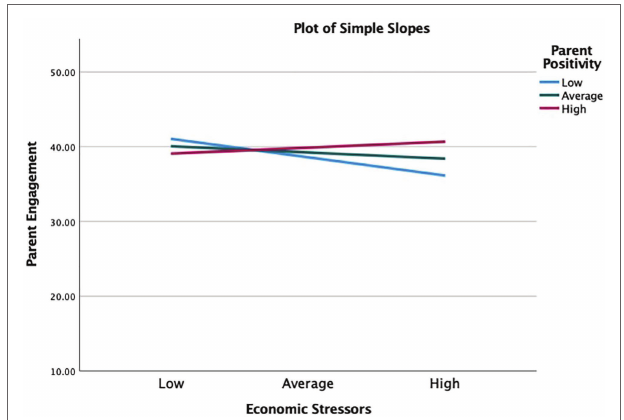
FIGURE 3 | Parent positivity moderating the effect of economic stressors on maternal mental health. High = 1 standard deviation above the sample mean, average = sample mean, and low = 1 standard deviation below the sample mean.